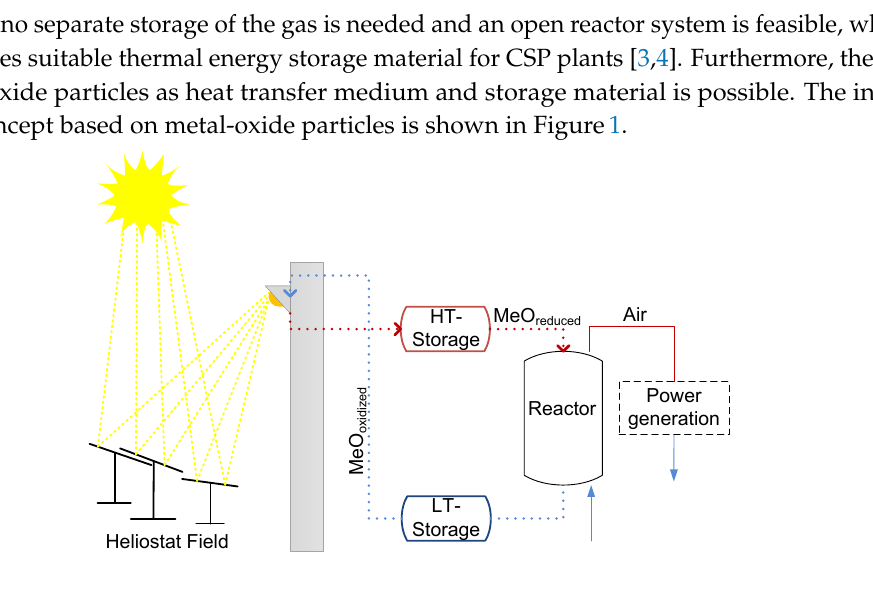
Figure 1. Concept of thermochemical energy storage based on metal oxide particles for solar tower applications. The metal oxide particles are cycled between a solar tower, high temperature (HT) storage, the reactor for discharging, and a low temperature (LT)